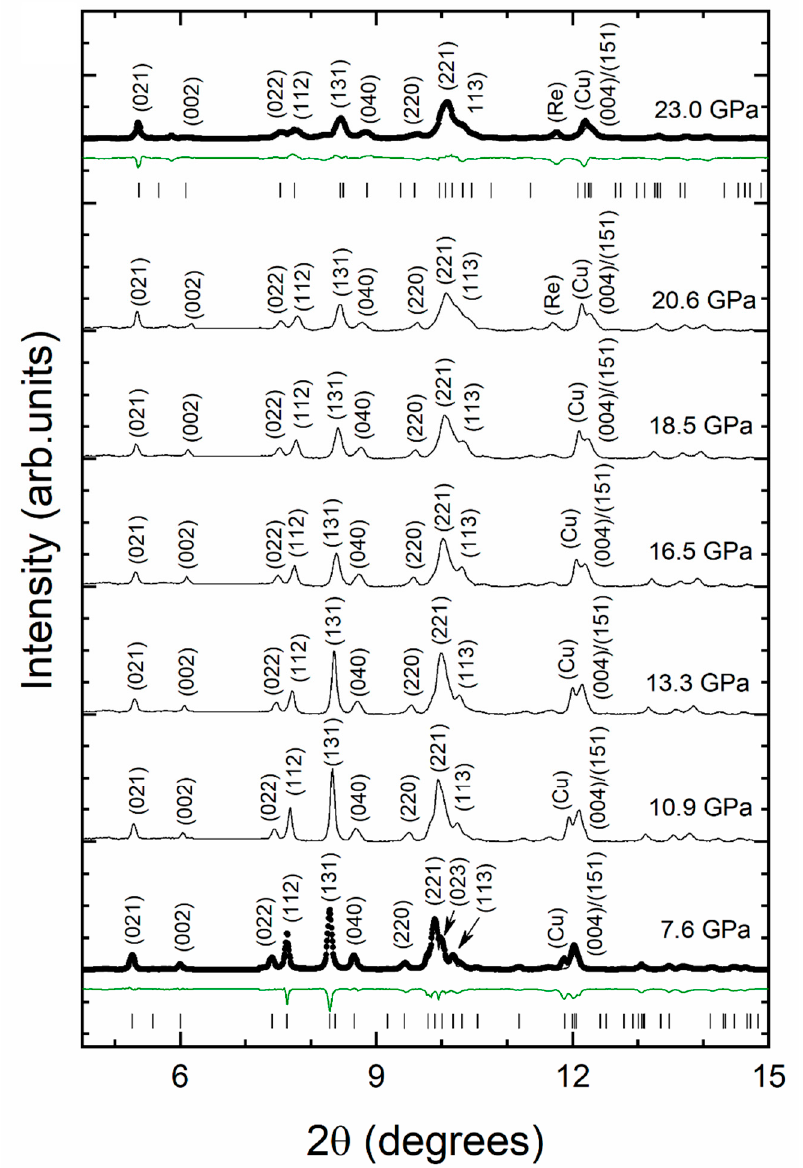
Figure 5. Integrated XRD patterns of Ni 3 V 2 O 8 measured from 7.6 to 23 GPa. Pressures are indicated on each pattern, and Bragg planes corresponding to the most intense reflections have been labeled. At the bottom and top, traces observed experimental data are shown with black symbols. The refinements are shown with black lines. The difference between the observed data and Le Bail refinement is shown in green. In the figure, it can be clearly seen the merging and broadening of peaks described in the text. From the hydrostatic pressure range of our experiments ( P ≤ 7.6 GPa), we have determined the linear compressibilities at ambient pressure, κ x = − 1 ∂ P , where x represents the unit cell lengths a , b , or c. The linear compressibilities are summarized in Table 2, where it can be seen that they increase following the sequence κ b < κ c < κ a . The a and c -axes have larger compressibilities than the b -axis by approximate factors of 1.5 and 1.3, respectively. A similar behavior has previously been observed in Zn 3 V 2 O 8